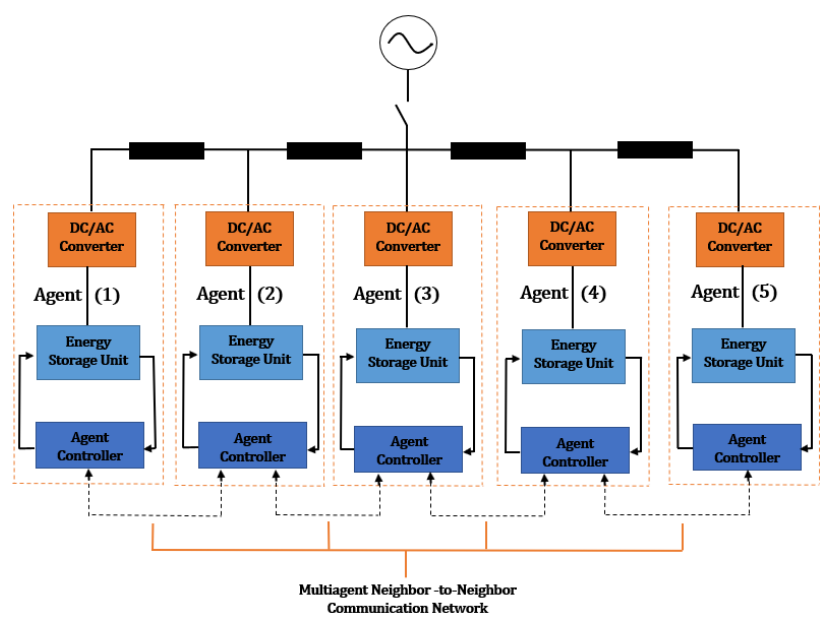
Figure 10. Distributed multiagent based control of AC Microgrid.